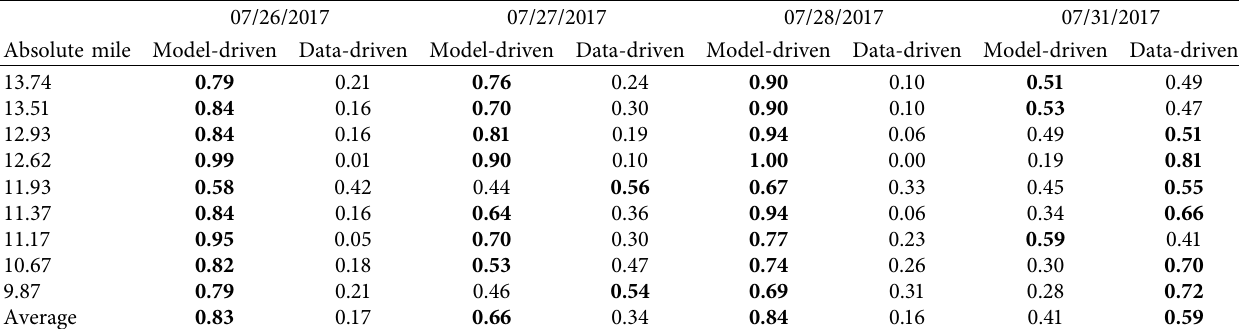
Table 9: Compare accounts for estimation between model-driven and data-driven in the peak